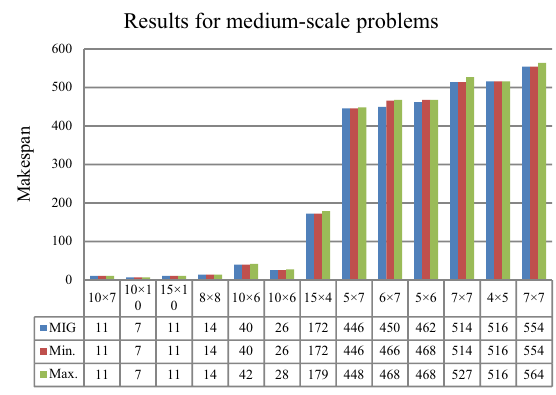
Figure 10 Results comparison for medium-scale